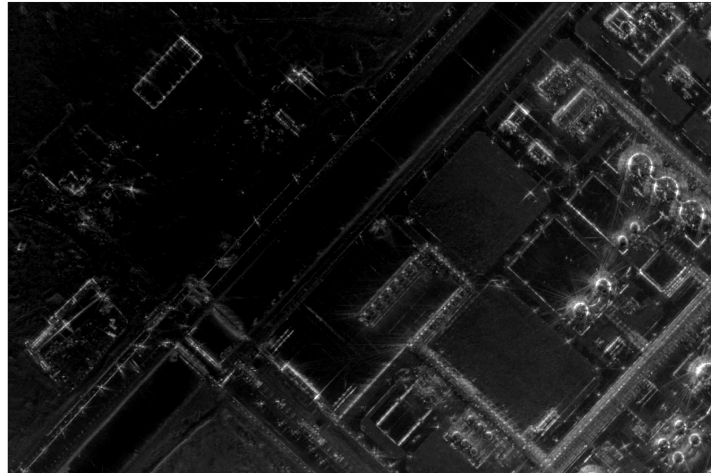
Figure 10. The likelihood ratio image obtained by Rayleigh approach.